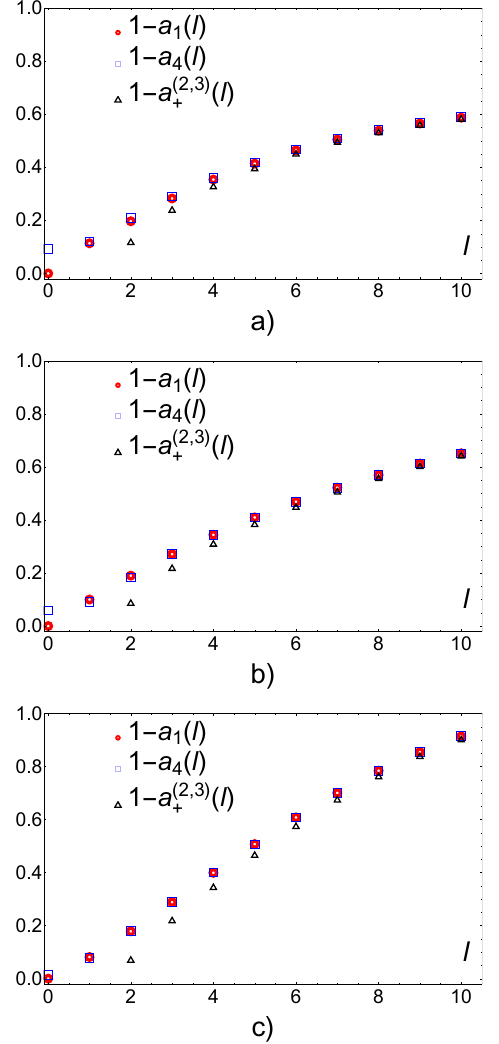
( 2,3 ) ( l ) ( ∆ ) as functions of l . The calculations were Figure 4. Quantities 1 − a 1 ( l ) ( ○ ), 1 − a 4 ( l ) ( ◻ ), 1 − a + performed for ( a ) sea water (Kopelevich’s model [47,48], ⟨ cos γ ⟩ = 0.89, and scattering matrix [49]), ( b ) the Henyey-Greenstein phase function and the Rayleigh scattering matrix, and ( c ) aqueous suspension of polystyrene spheres (diameter d = 0.993 µ m and wavelength λ = 633